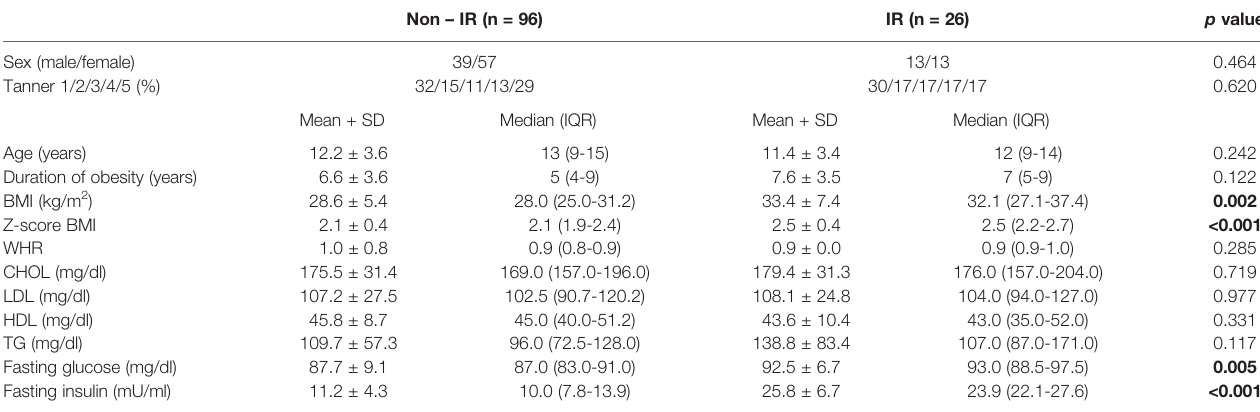
TABLE 1 | Clinical phenotype of the non-insulin resistant (non-IR) and insulin resistant (IR)